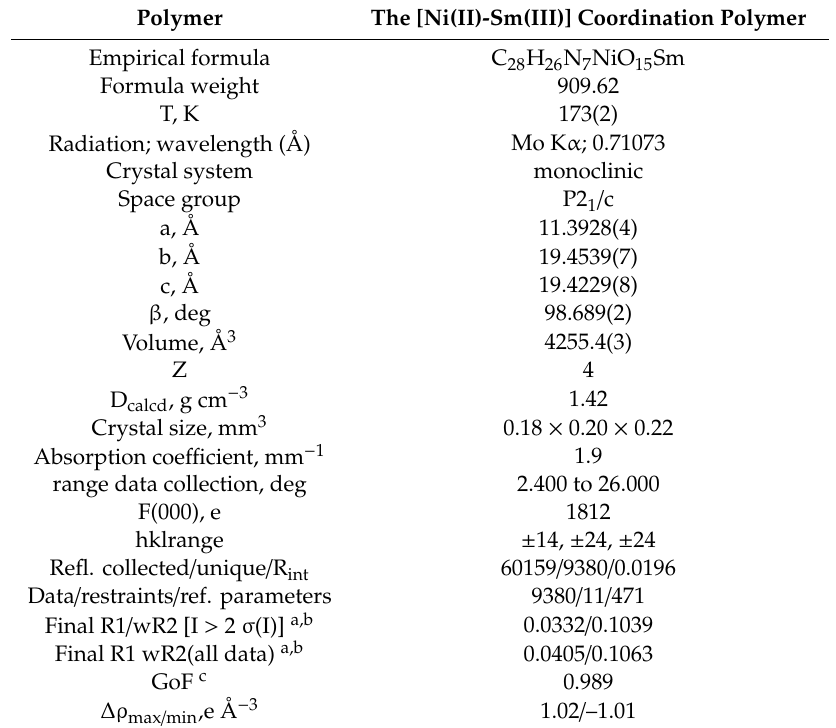
Table 1. Crystal data and structure refinement for the title